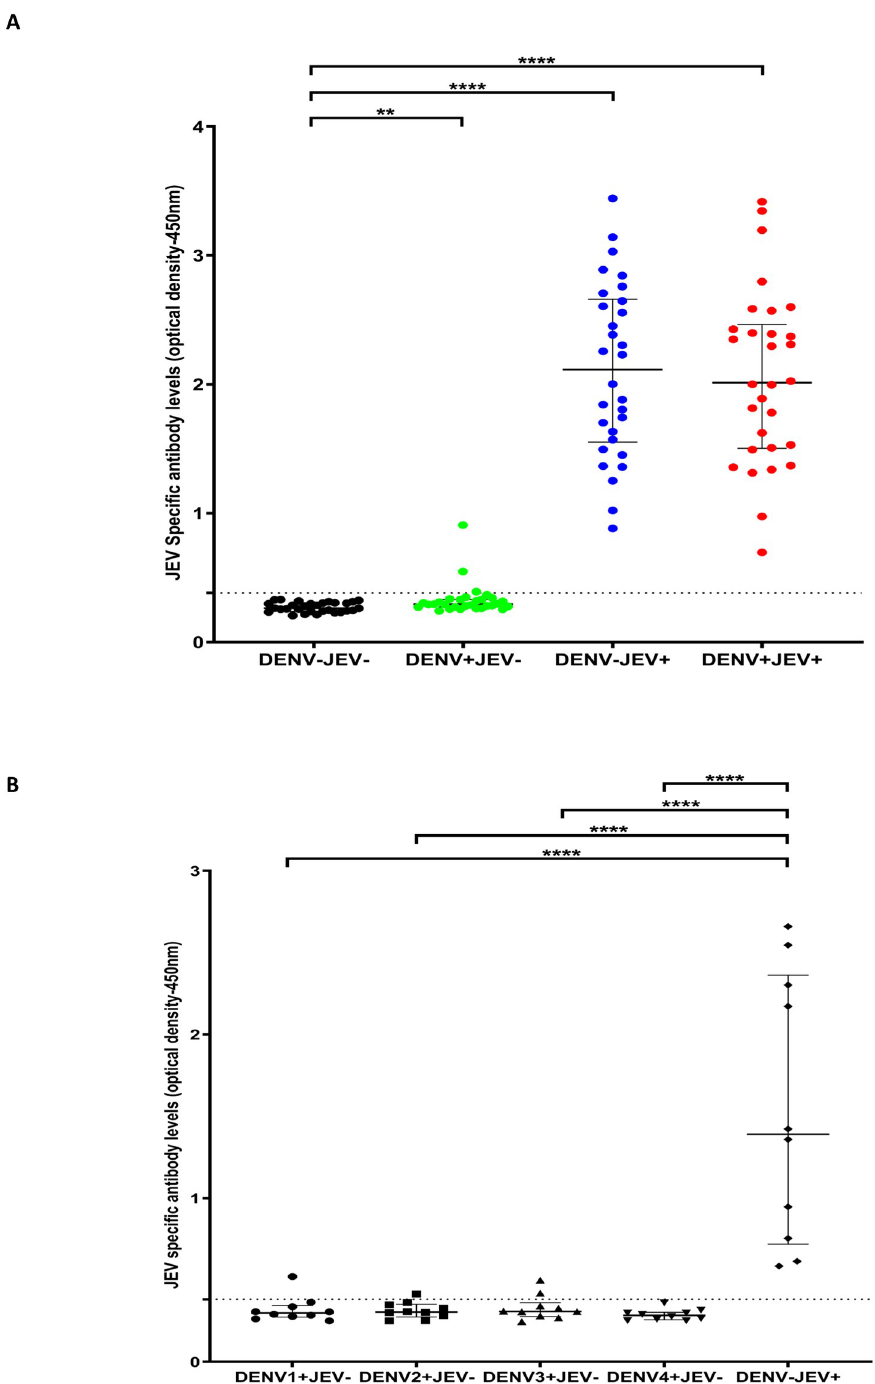
Fig 2. IgG antibody levels for a JEV-specific peptide pool in individuals with varied DENV and JEV seropositivity. Antibody responses were measured by ELISA to the JEV pool of peptides (P6, P7, P8, P9, P10, P12 and P13) in (A) those who were both JEV and DENV seropositive (JEV + DEV + , n = 30), JEV seropositive but seronegative for DENV (JEV + DEV - , n = 30), DENV seropositive but JEV seronegative (JEV - DENV + , n = 30) or seronegative for both (JEV - DENV - , n = 30). (B) Who were seronegative for JEV and previously had primary DENV infection due to either DENV1 (n = 10), DENV2 (n = 10), DENV3 (n = 10) or DENV4 (n = 10) and in individuals who were immunized for JEV but DENV seronegative (DENV - JEV + , n = 10) Error bars indicate the median and the interquartile range. The horizontal dotted line represents the cut-off value of 0.382, which was considered as the mean, ± 3SD of the optical